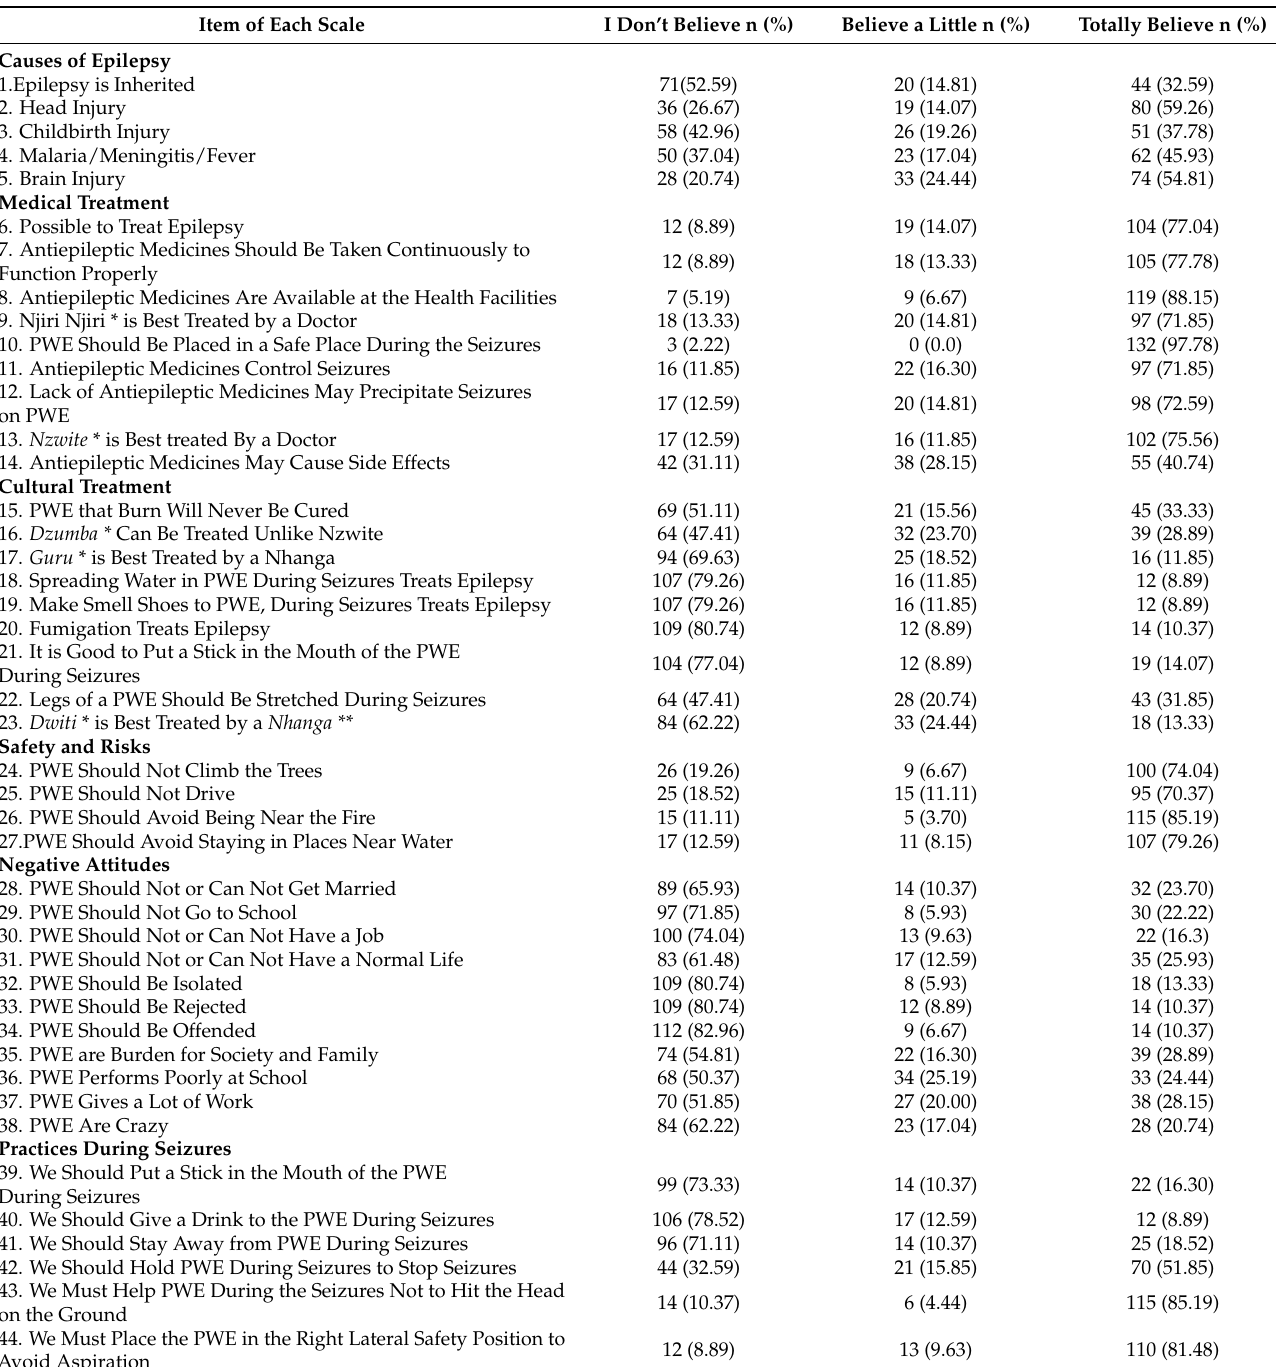
Table 3. Proportion of response of each item of the questionnaire of knowledge, attitudes, and practices towards epilepsy of 135 CHWs in Sofala Districts, Mozambique,